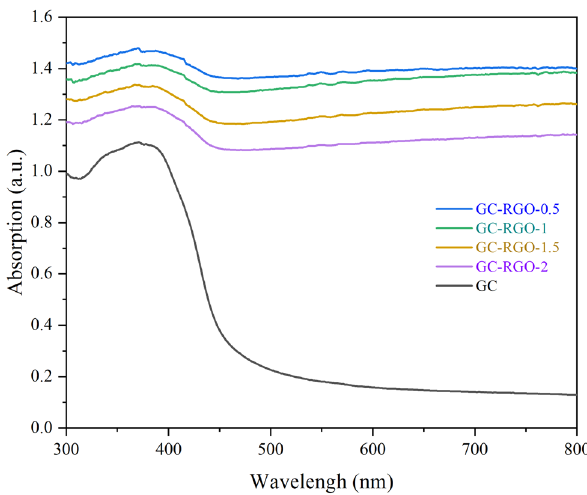
Figure 6: The UV - Vis DRS of samples.